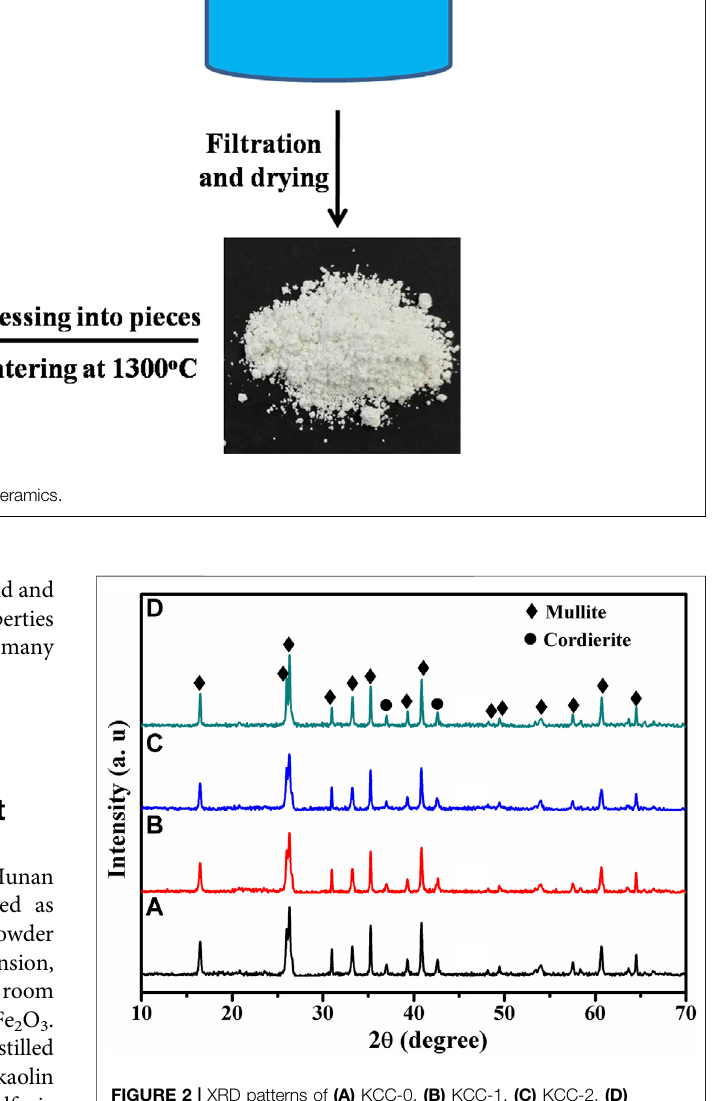
FIGURE 2 | XRD patterns of (A) KCC-0, (B) KCC-1, (C) KCC-2, (D)